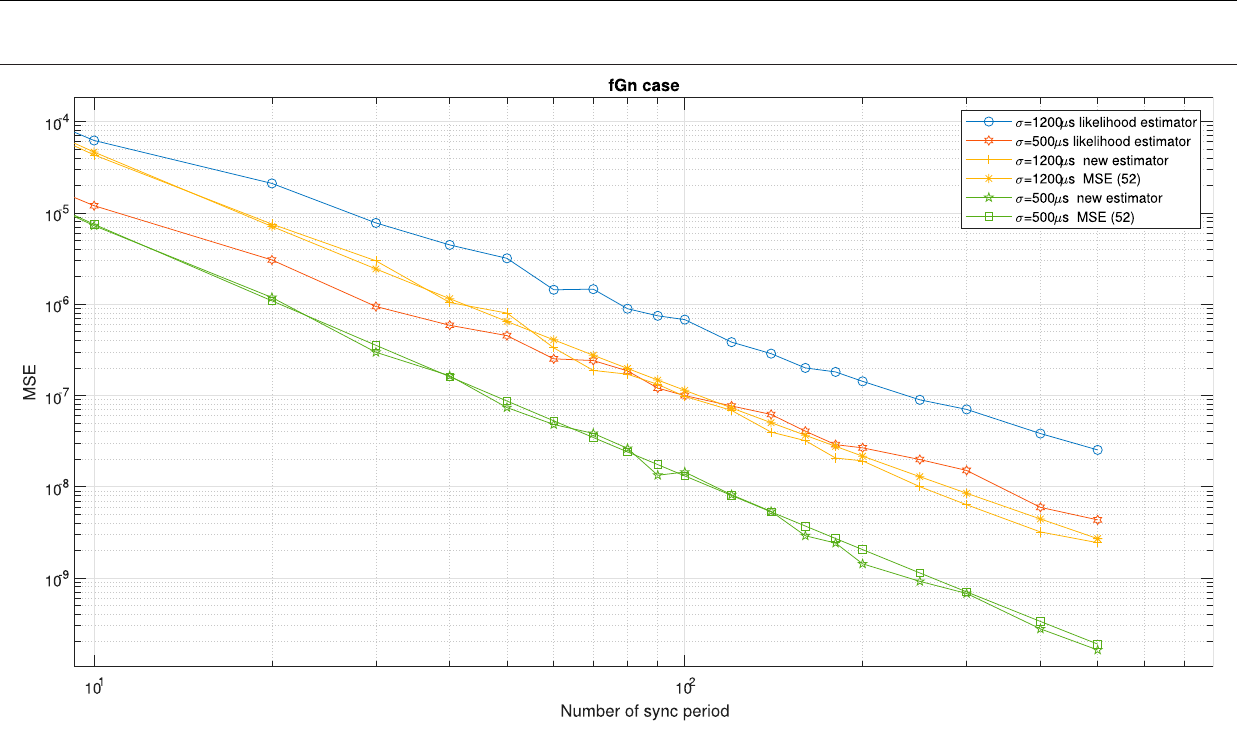
Frontiers in Physics |